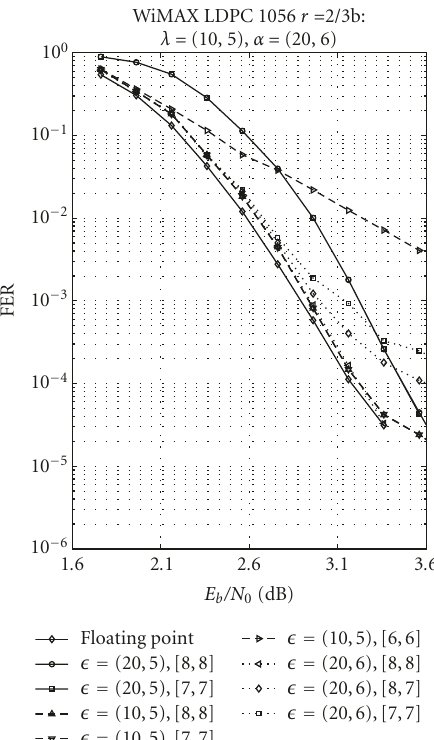
Figure 16: WiMAX LDPC code: e ff ects of the quantization on the state-metric recursions within the CN processor. Table 3: Optimal fixed-point parameters of the LDPC decoder. Signal Dynamic range ( A ) No. of bits ( N )